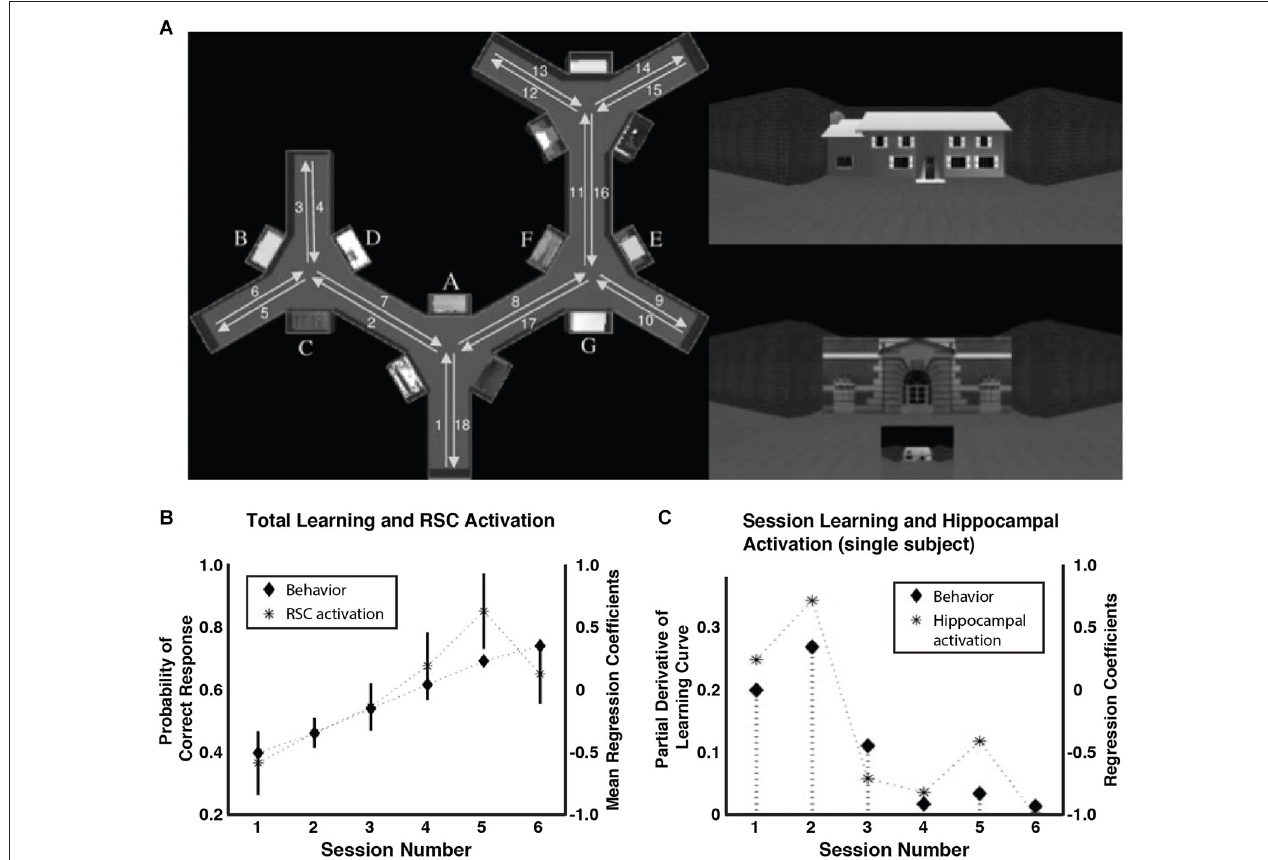
press the relative position of the small building, imagining that they were standing in front of the large building. (B) RSC BOLD activation increased along with behavioral accuracy over the course of training. (C) In contrast, hippocampal activation was specifically correlated with the slope of the learning curve (data from one participant shown). Adapted from Wolbers and Buchel